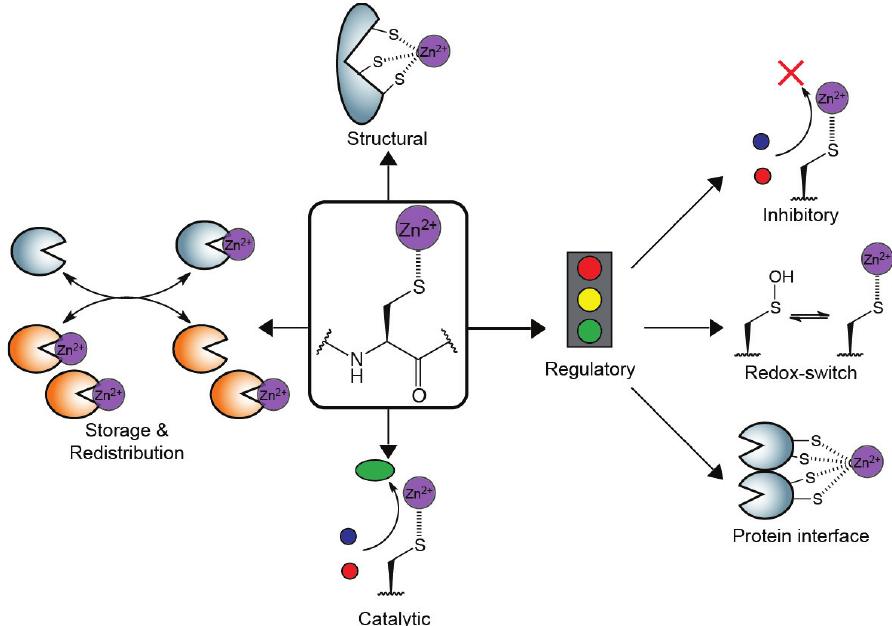
Figure 1. Zinc ions (Zn 2+ ) have the ability to be chelated to cysteine residues within protein scaffolds. These resulting Zn 2+ -cysteine complexes participate in a variety of functional roles, including structural, catalytic, regulatory and transport. Regulatory mechanisms consist of inhibitory, redox-switches, and protein-interface